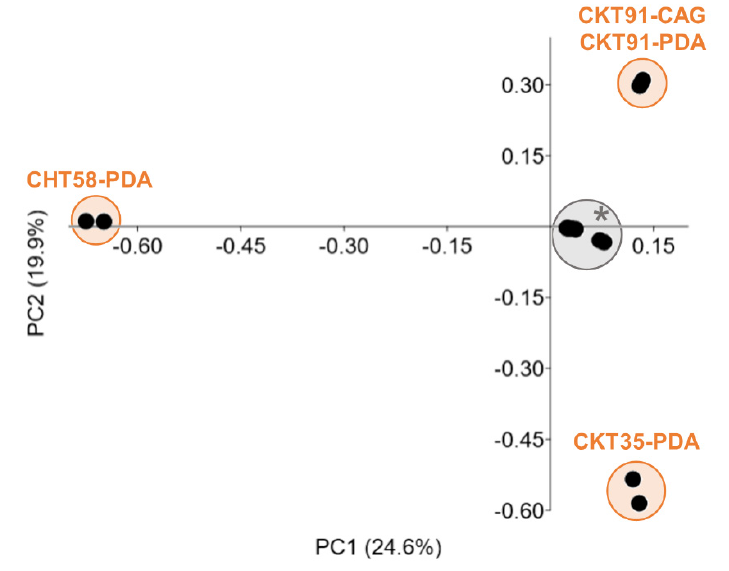
Figure 5. UPLC-MS / MS-based metabolite profiling of 12 pre-selected bioactive tunic-derived fungal extracts. The PCoA plot (Euclidean distance) was calculated using a pre-processed peak list based on UPLC-MS / MS data. *: cluster comprises the following extracts: CHT37-PDA, CHT56-CAG, CKT49- PDA, CKT81-CAG, CKT81-PDA, CKT84-CAG, CKT84-PDA, CKT85-CAG.